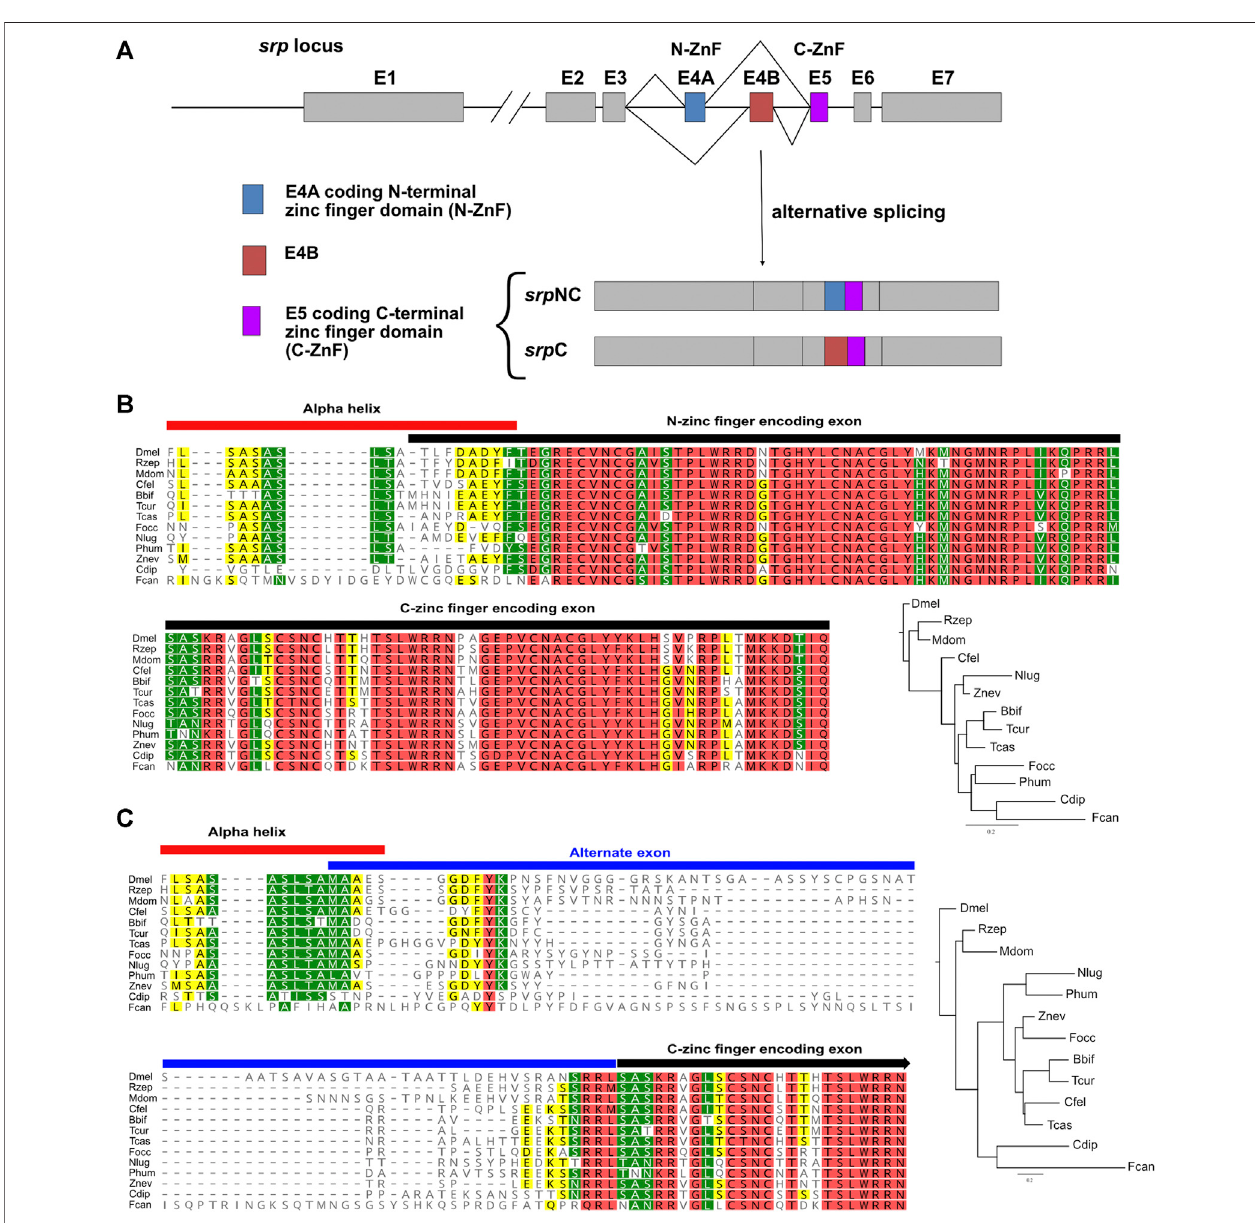
FIGURE 1 | The two Serpent isoforms are conserved in various arthropods. (A) Schematic representation of the wild-type Drosophila melanogaster srp locus. Exons(E)arerepresentedbyboxesandintronsbylines.Alternativelysplicedexons4A(E4A)and4B(E4B)arecoloredblueandred,respectively,constitutiveexon5(E5) is colored purple, and all other exons are shown in grey. E4A and E5 code respectively for N-ZnF and C-ZnF domains. Transcripts containing E4A and E5, and those containingE4BandE5arecalled srpNC and srpC ,respectively.Alignmentoftheproteinportionof Drosophilamelanogaster (Dmel)SrpNCencodedbypartofexon 3,theN-ZnFencodingexon4A,andtheC-zinc fi ngerencodingexon5 (B) ,aswellastheportionofDmelSrpCencodedbypartofexon3,thealternateexon4B,andthe C-ZnF encoding exon 5 (C) with sequences from insect orders Diptera Rhagoletis zephyria (Rzep) and Musca domestica (Mdom), Siphonaptera Ctenocephalides felis (Cfel), Hymenoptera Bombus bifarius (Bbif) and Temnothorax curvispinosus (Tcur), Coleoptera Tribolium castaneaum (Tcas), Thysanoptera Frankliniella occidentalis (Focc), Hemiptera Nilaparvata lugens (Nlug), Psocodea Pediculus humanus corporis (Phum), Dyctyoptera Zootermopsis nevadensis (Znev), Palaeoptera Cloeon dipterum (Cdip) and from the non-insect Hexapod class Collembola Folsomia candida (Fcan). Phylogenetic trees are built using FastTree (Geneious prime) from the correspondingalignment.Thetreesarerooted usingtheDmelsequenceastheoutgroup. Conserved residues arecoloredaccordingtotheirsimilarity:red100%,green 80 – 100%, yellow 60 – 80% and no color less than 60% similar.